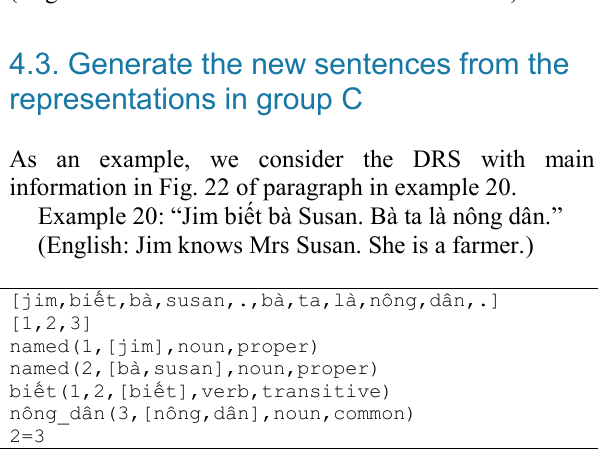
Figure 22. The DRS with main predicates of two- sentences Vietnamese paragraph “Jim biết bà